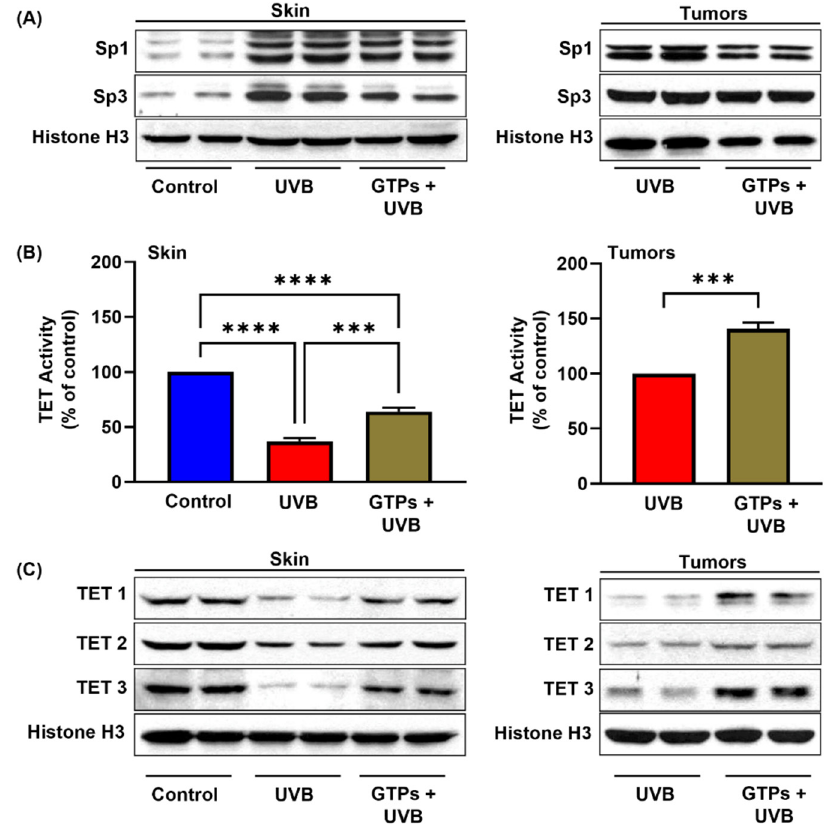
Figure 2. Effect of GTPs on transcription factors, TET activity, and TET protein expression in skin and tumors of SKH-1 hairless mice. After 24 weeks, all mice were euthanized, and tumors and skin were harvested. Nuclear lysates were prepared and subjected to Western blot analysis for the expression level of transcription factors (Sp1 and Sp3) ( A ). Effect of GTPs on TET activity ( B ) and TET 1, TET 2, and TET 3 protein expression ( C ). Data are presented as a percentage of control (assigned as 100%) ± S.D. In the Western blot, each column represents a pool of three samples obtained from three different mice ( n = 6). Significant increase between UVB alone vs. UVB + GTPs, *** p < 0.0002, **** p < 0.0001.